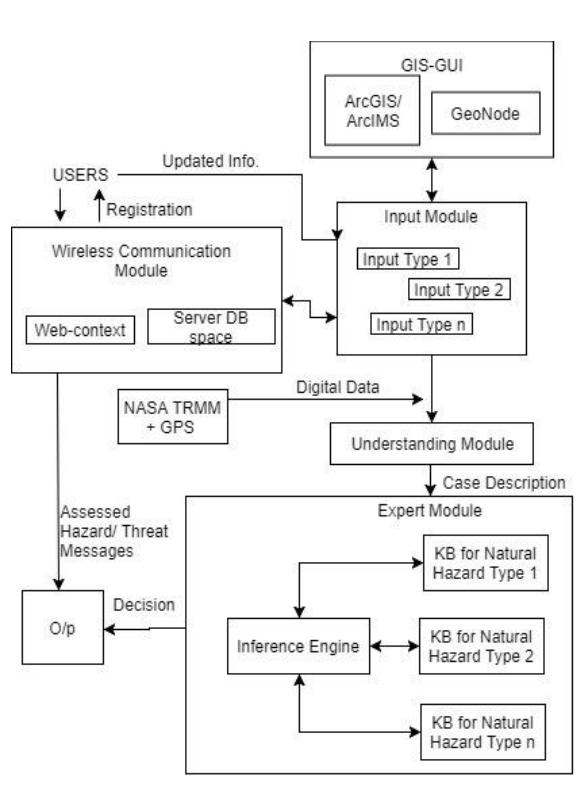
Figure 2. GIS Data Flow Diagram of SMACiSYS